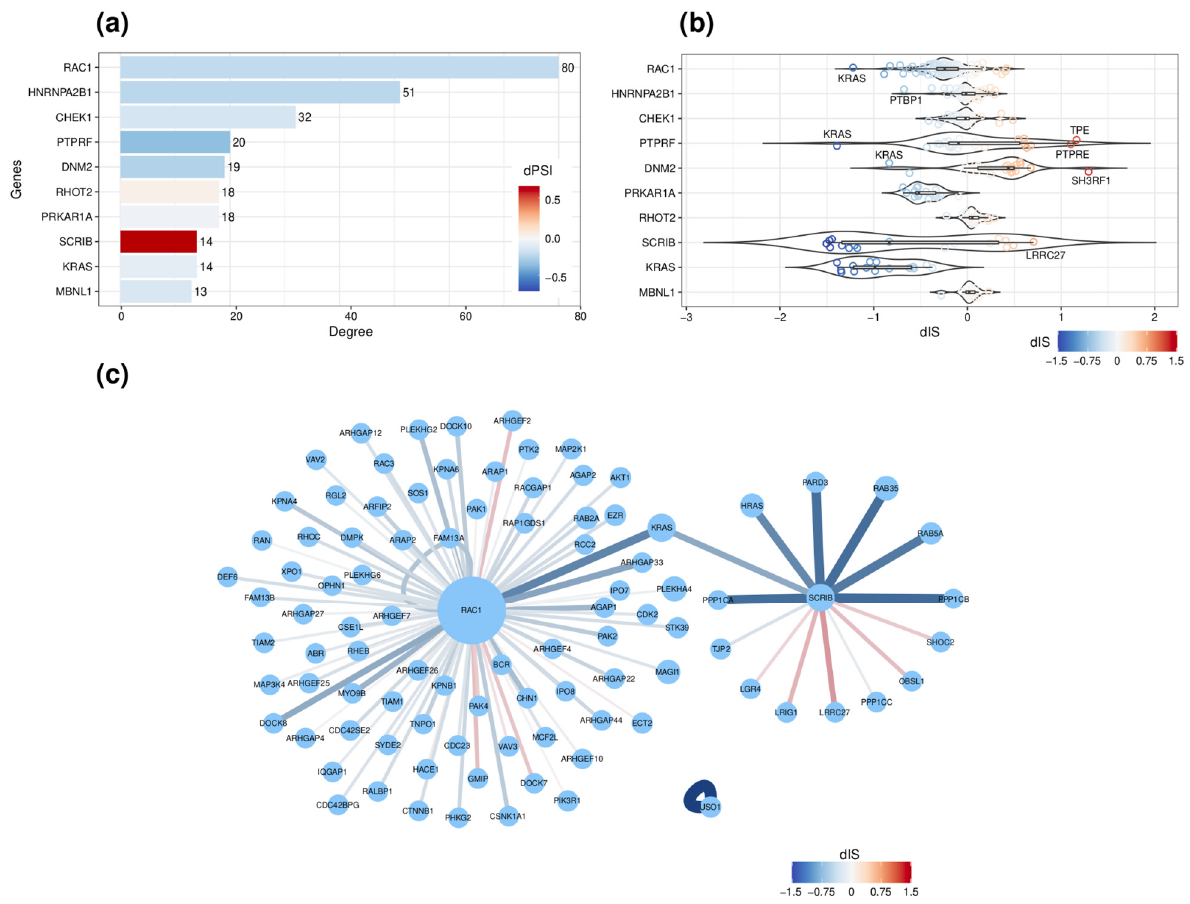
Figure 4. Summary of the protein interaction network and their features derived from the silencing of ESRP1/2. ( a ) Top 10 hub nodes ordered by degree of subnetwork, consisting of genes with significant ASE in our analysis and whose exon inclusion/exclusion levels correlated with ESRP1/2 levels in ER+ BC. The color code of the bars is based on the dPSI of the most significant ES event characterizing each gene. ( b ) Violin plot showing the distribution of dIS of each hub shown in ( a ). ( c ) A highlight of the most changing dIS values in subnetwork, focusing on the PCR-validated targets RAC1, SCRIB, and USO1 and their interactions. The color code of the interactions is based on the dIS value, and width is proportional to the absolute value of dIS.